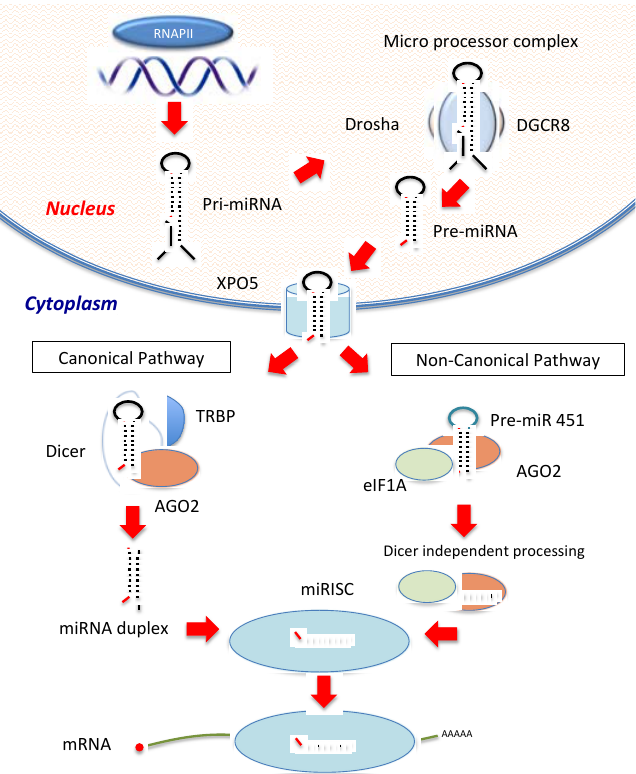
Figure 1. MiRNAs Biogenesis Pathway; Canonical Pathway; First, miRNAs are transcribed from the genome by RNA polymerase II (RNAP II) into primary transcripts (pri-miRNA) in the nucleus. Second, pri-miRNAs are cleaved into precursor miRNAs (pre-miRNAs) by the ribonuclease (RNAase) III family enzyme Drosha, which forms a micro-processor complex with the DNA-binding protein DGCR8. Third, miRNA precursors (pre-miRNAs) are exported to the cytoplasm by a Ran-GTP-dependent dsRNA-binding protein, Exportin-5 (XPO5). Fourth, Dicer, an RNAase III-type endonuclease, together with transactivating response RNA-binding protein (TRBP) and Kinase R-activating protein (PACT), cleaves pre-miRNAs in the cytoplasm. Finally, the guide miRNA generated by Dicer is loaded onto the RNA-induced silencing complex (RISC) consisting of Dicer, TRBP and PACT and Argonaute 2 (AGO2) and consequently binds to the 3 ′ UTR of target genes, inducing degradation or translational inhibition of the target mRNA. Non-canonical Pathway (Dicer independent); Following transportation from nucleus to cytoplasm, pre-miR-451 is directly assembled onto AGO2-eIF1A complex. Consequently, the pre-miR-451 hairpin structure is cleaved by the Argonaute RNAase H-like motif to form the single strand mature miR-451. The generated mature miR-451 binds to the 3 ′ UTR,